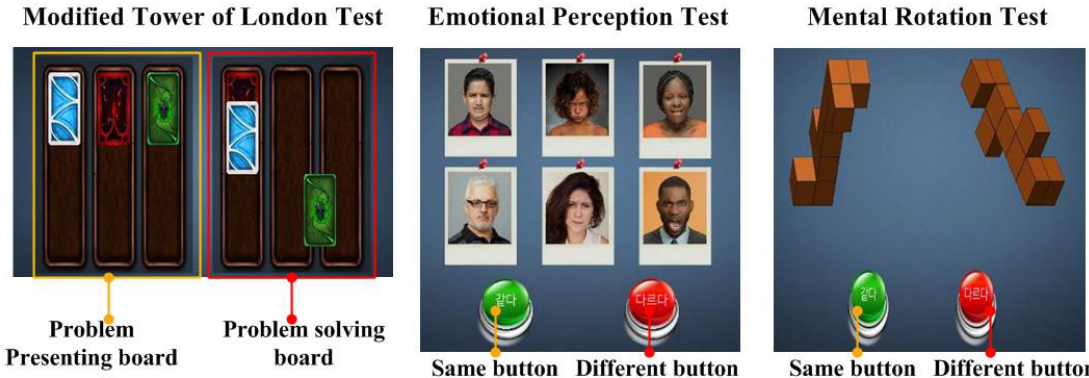
Figure 1. Tasks to assess cognitive functions.